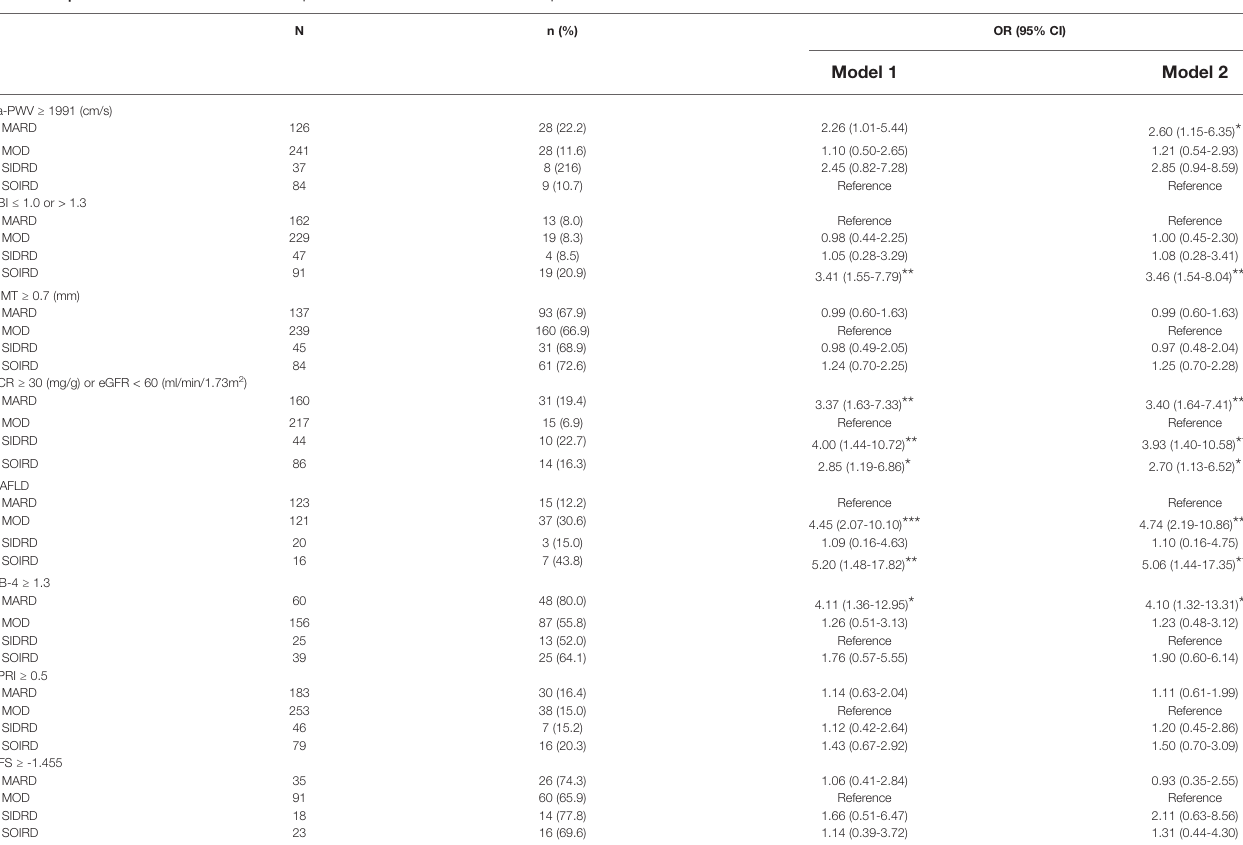
TABLE 2 | Risks of diabetes-related complications in 4 clusters at